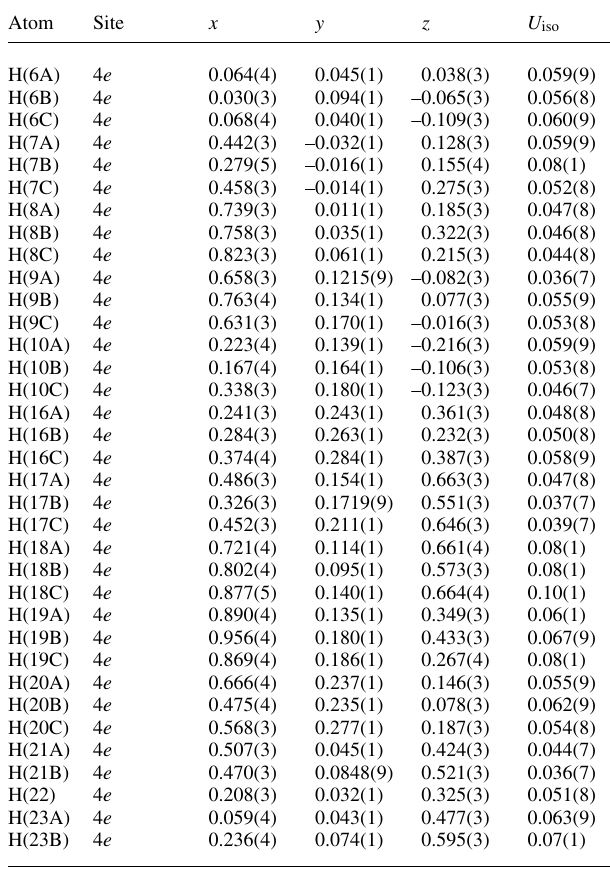
Table 2. Atomic coordinates and displacement parameters (in Å 2 )